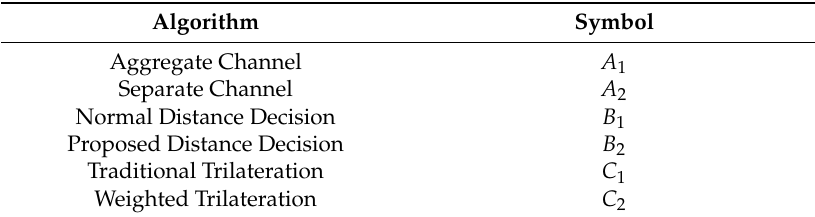
Table 4. Symbols denoting di ff erent algorithms.